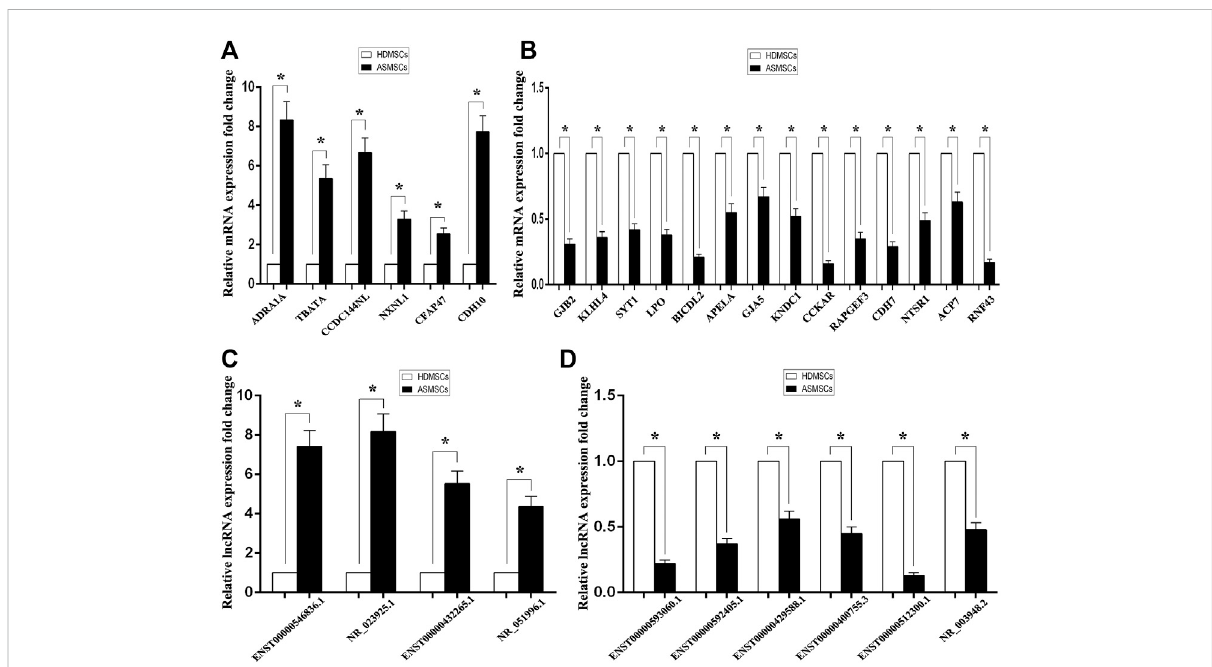
FIGURE 3 Con fi rmation of DE mRNAs and DE lncRNAs by qRT – PCR. The expression levels of the top 20 DE mRNAs and top 10 DE lncRNAs were con fi rmed via qRT – PCR. As shown in (A) and (B) , 6 mRNAs were upregulated and 14 mRNAs were downregulated in ASMSCs. As depicted in (C) and (D) , 4 lncRNAs were upregulated and 6 lncRNAs were downregulated in ASMSCs. Data are presented as the means ± SDs. * p < 0.05.